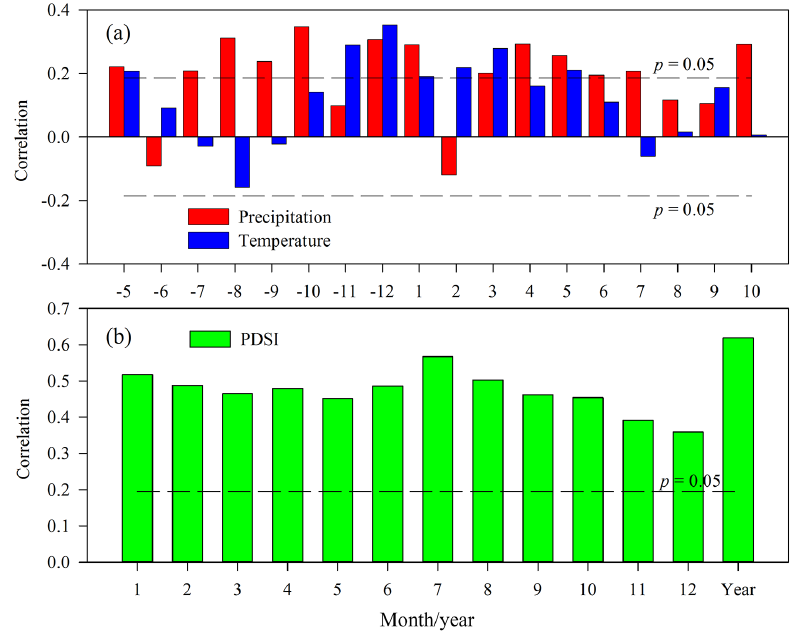
Figure 3. Pearson correlation coefficients between tree-ring index of Pinus sylvestris var. mongolica and the monthly total precipitation, mean temperature (a) and Dai-PDSI (b) . Significant correlations ( p < 0 . 05) are indicated by above or below the 95% confidence line (dashed line). The minus sign (“ − ”) in the abscissa represents the previous year; for example, “ − 7” represents the previous July.